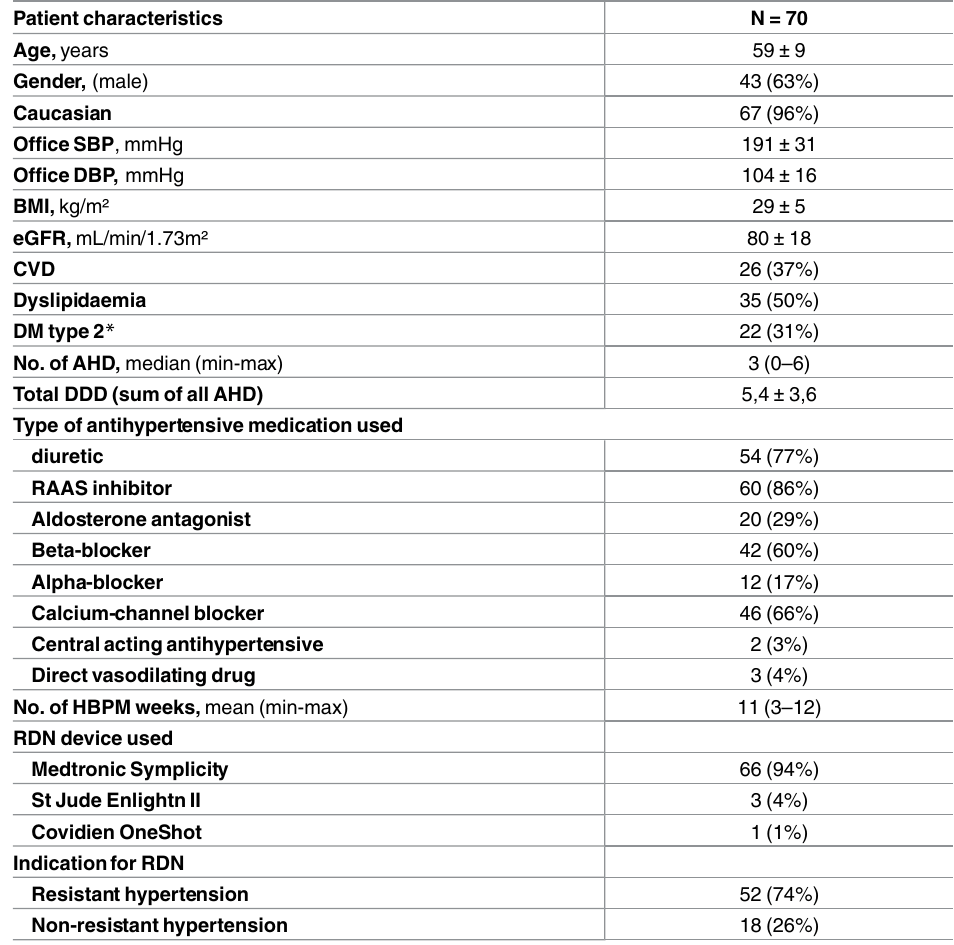
Table legend: SBP systolic blood pressure, DBP diastolic blood pressure,BMI body mass index,